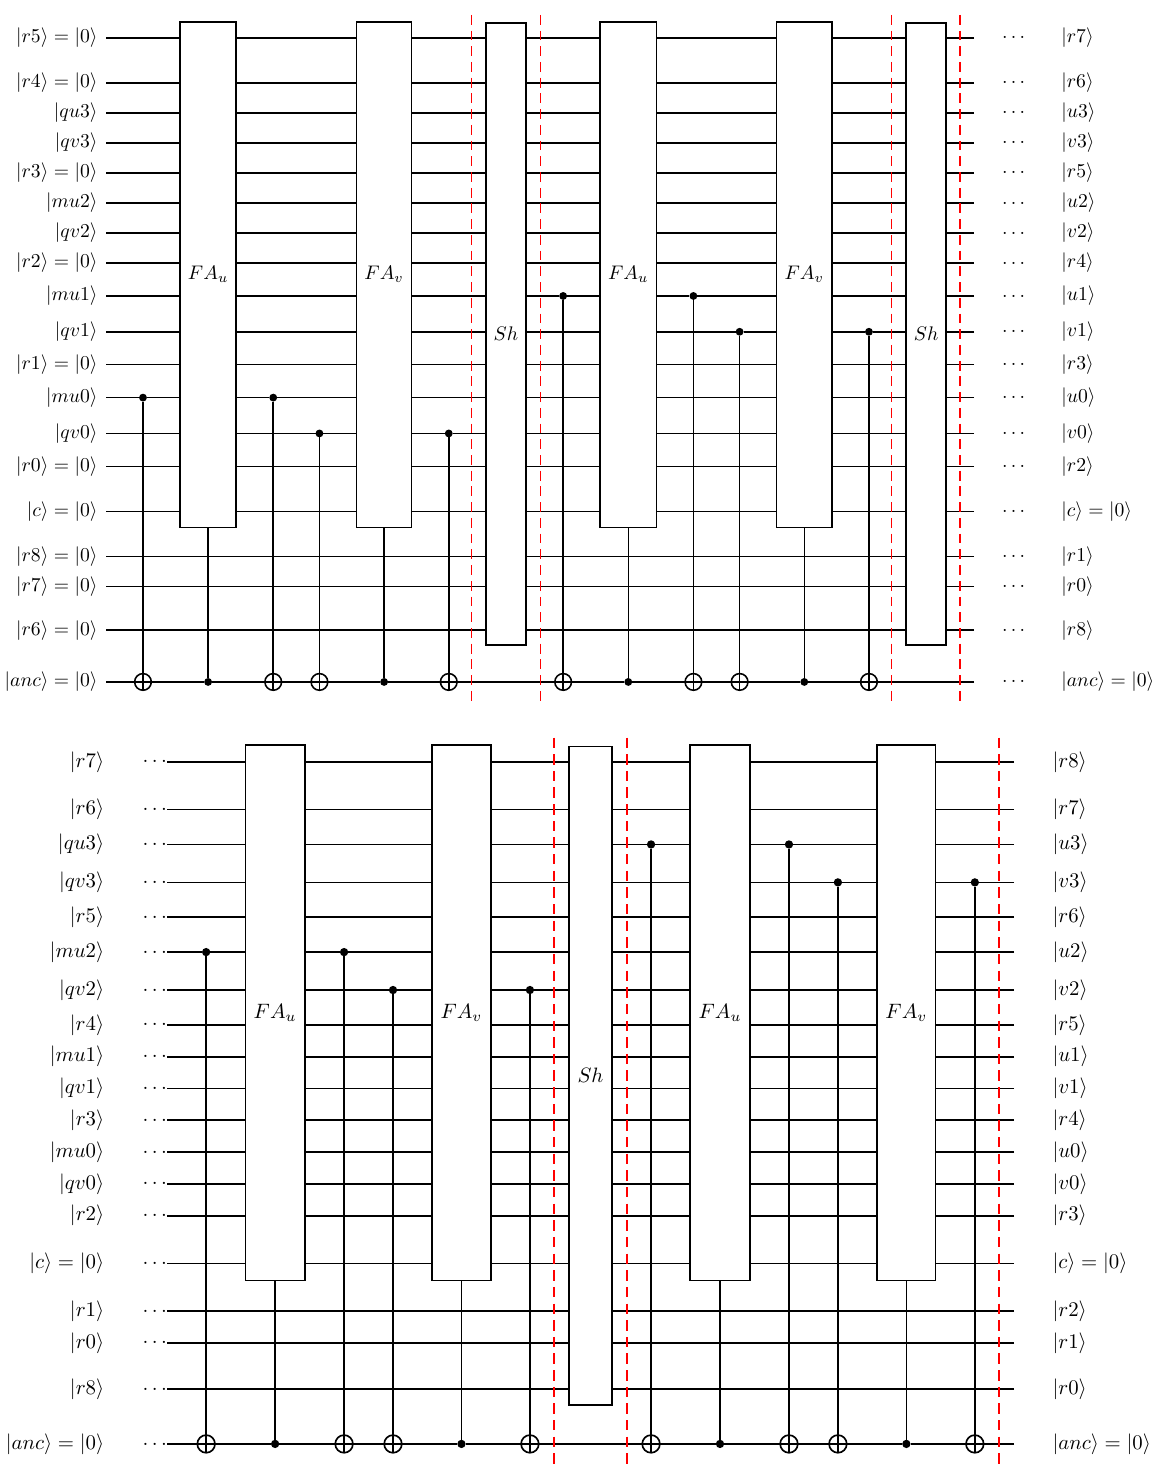
Figure 12. Design EKin2D3 with ( N M + 1 )